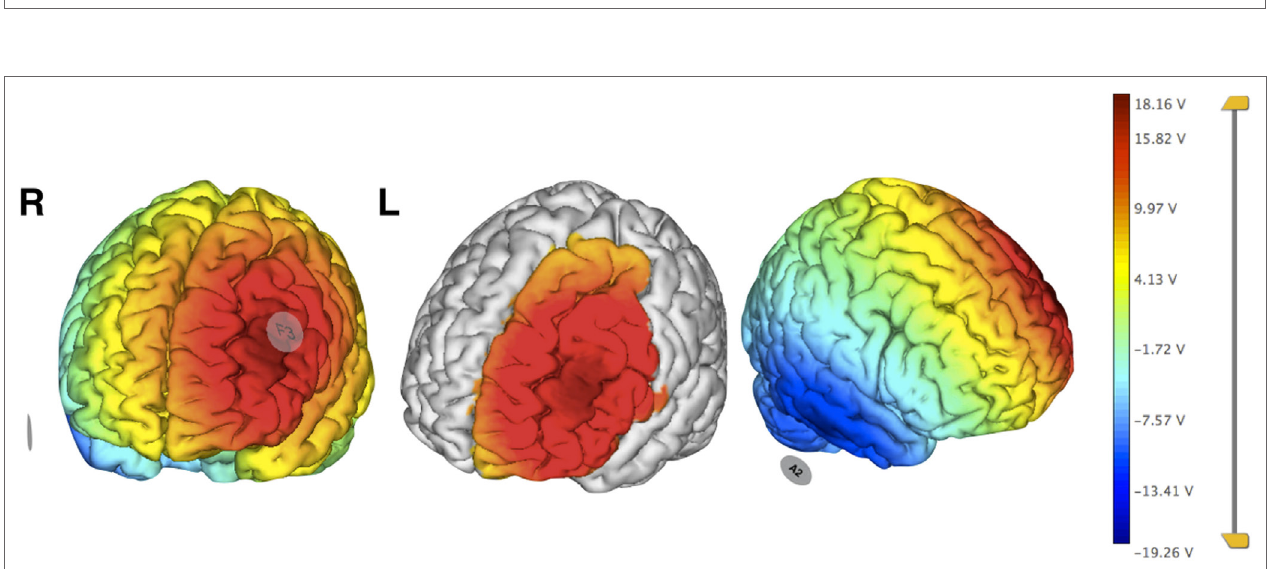
FIgURe 2 | (a) Sleep interictal scalp EEG shows epileptiform interictal discharges and focal slowing over the left fronto-central regions. Filters: 0.3–70 Hz. Notch: 60 Hz. Sensitivity: 7 µV/mm. (B) Ictal scalp video-EEG recording illustrates a clinical seizure onset over the left frontal central regions characterized by a fast and low voltage pattern with clonic right hemi-body seizures with Jacksonian march without loss of consciousness and preserved language. Filters: 1.0–35 Hz. Notch: 60 Hz. Sensitivity: 100 μ